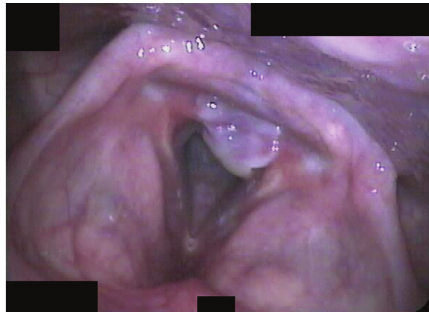
Figure 2: Formation of posterior glottic adhesion with fully mobile vocal